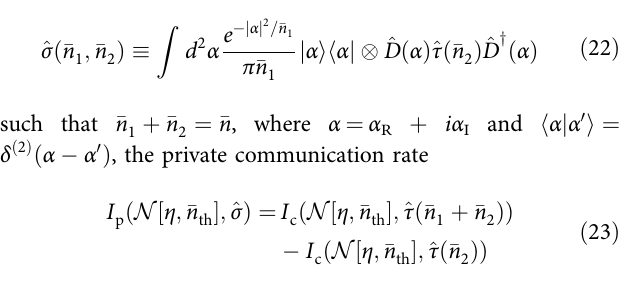
(coherent information) and backward (reverse coherent informa- tion) strategies, as can be seen from the bottom panels of Fig. 4.